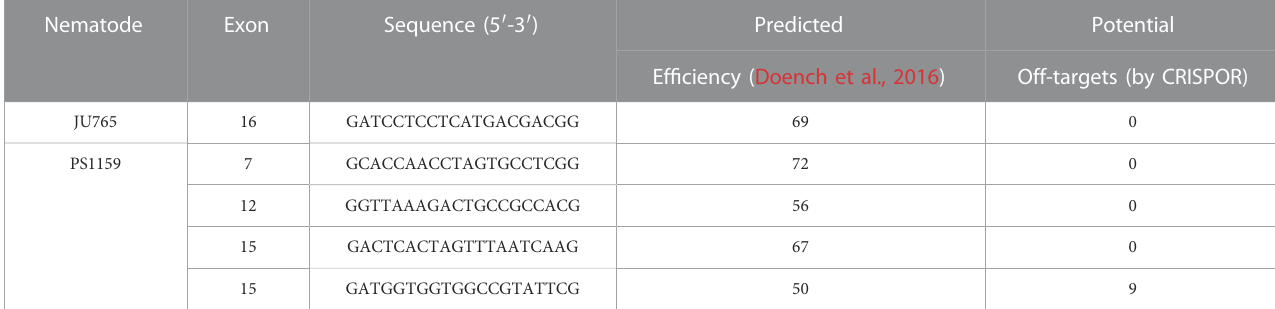
TABLE 2 List of gRNAs used for this